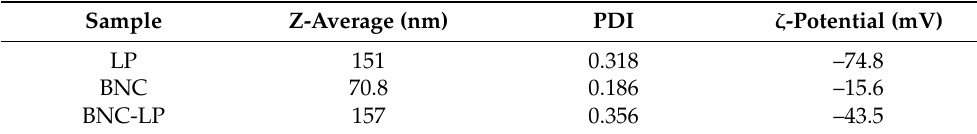
Table 1. Sizes and surface charges of BNCs, LPs, and BNC-LP complexes.